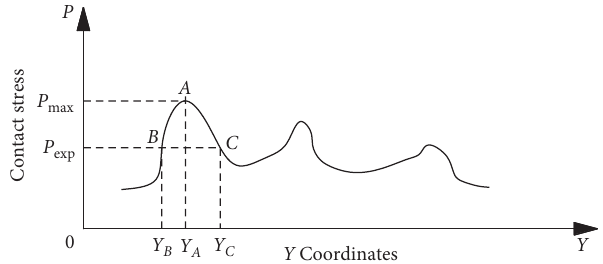
Figure 6: Schematic for the maximum wheel-rail contact stress distribution.